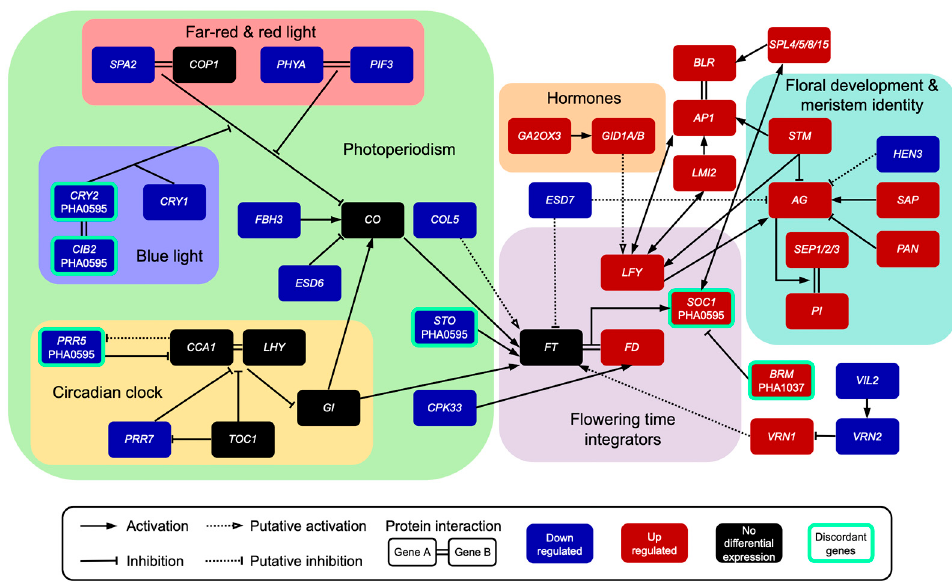
Figure 8. A hypothetical model for the regulatory network of the common bean’s floral transition under short-day length conditions. Down-regulated and up-regulated genes are indicated in blue and red, respectively. Discordant genes are squared in cyan and the name of the genotype in which is differentially expressed according to the color of its expression status. Gene interactions within the flowering pathways were inferred from Arabidopsis publications, most of them included in the database FLOR-ID [18]. Gene abbreviations are explained in Table 1. Evolutionarily conserved genes involved in Arabidopsis flowering pathways are listed in Tables S18–S20.